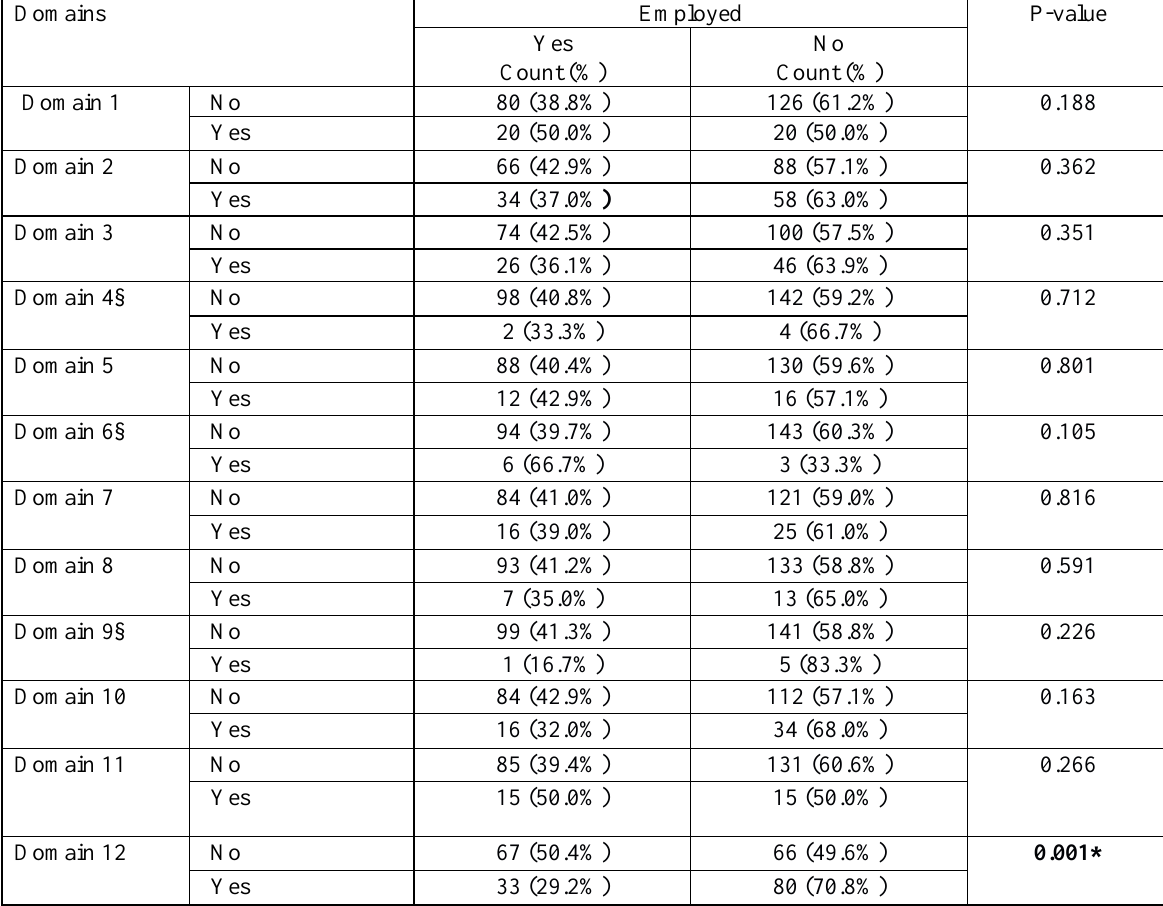
Table 6. The relationships between the patient employment status and the study